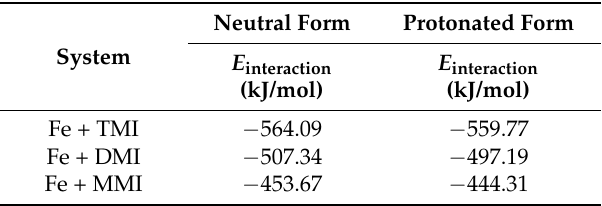
Figure 7. Side and top views of the final adsorption of the protonated forms of the inhibitor molecules on the Fe (110) surface in solution: ( a ) Side view; ( b ) top view. Table 6. Selected energy parameters obtained from molecular dynamic (MD) simulations for adsorption of inhibitors on the Fe (110)